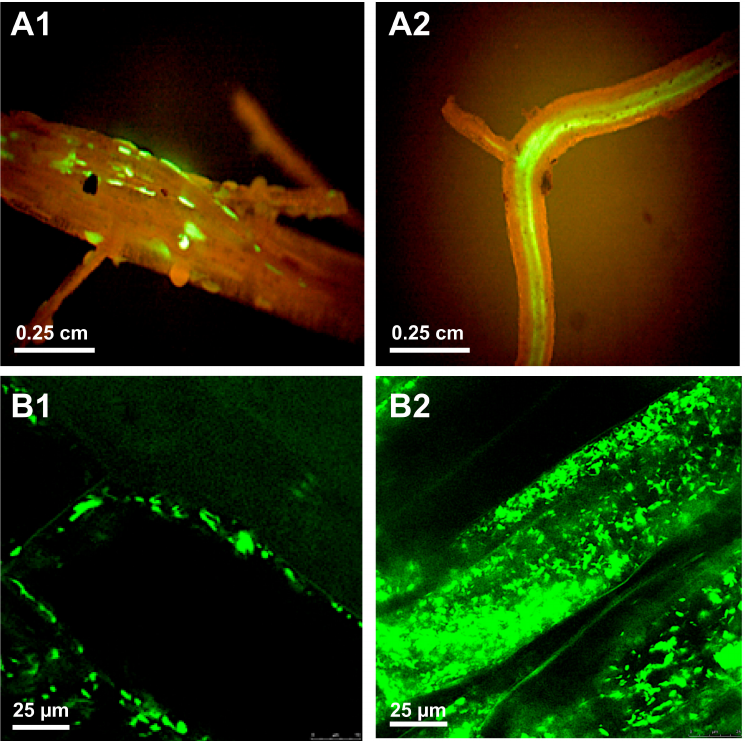
Figure 1. Colonization of potato roots with green fluorescent protein (GFP)-tagged Dickeya solani. Bacterial colonization of roots can be evaluated using either epifluorescence stereo microscopy to visualize the spread of the D. solani strain IPO2254 (see Table 1) on the scale of the organ (microcolonies on the rhizoplane and invasion of the vascular tissue, ( A1 , A2 ), respectively) or by confocal scanning laser microscopy to locate the bacterium on the level of the plant cell (intercellular and intracellular colonization, ( B1 , B2 ), respectively). For technical experimental details please see reference [97]. (Courtesy of Dr. Jan van der Wolf, WUR-PRI, Wageningen, the